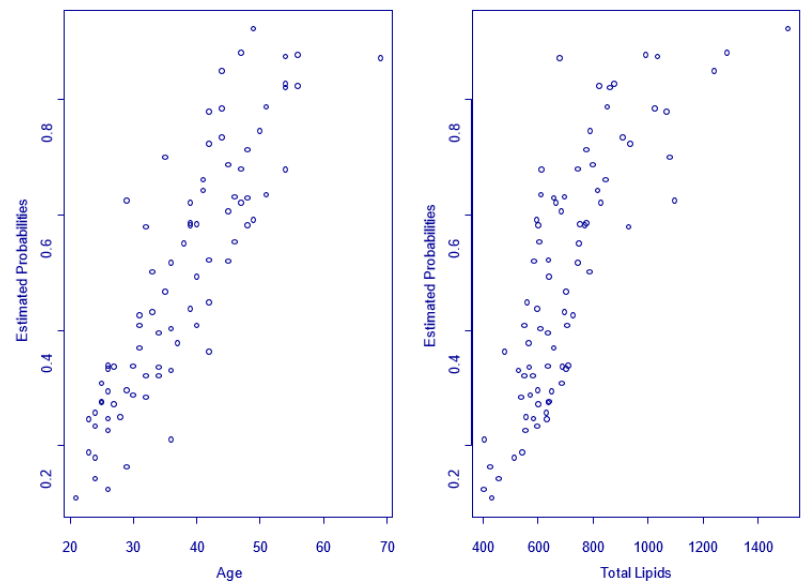
Figure 9. The probabilities to develop ED for all patients included related to age and total lipids.